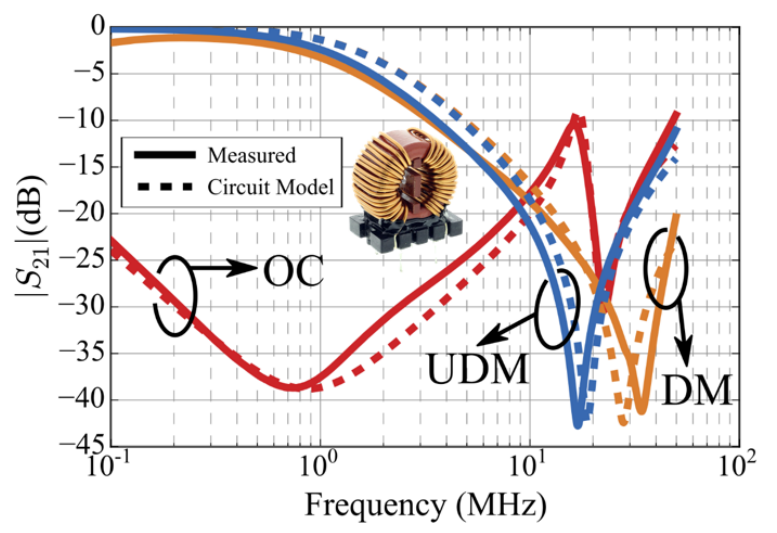
Figure 8. Magnitude | S 21 | for the CMC listed as Würth Elecktronik 744824622 (2.2 mH) in Table 2, using the setups in Figures 3 and